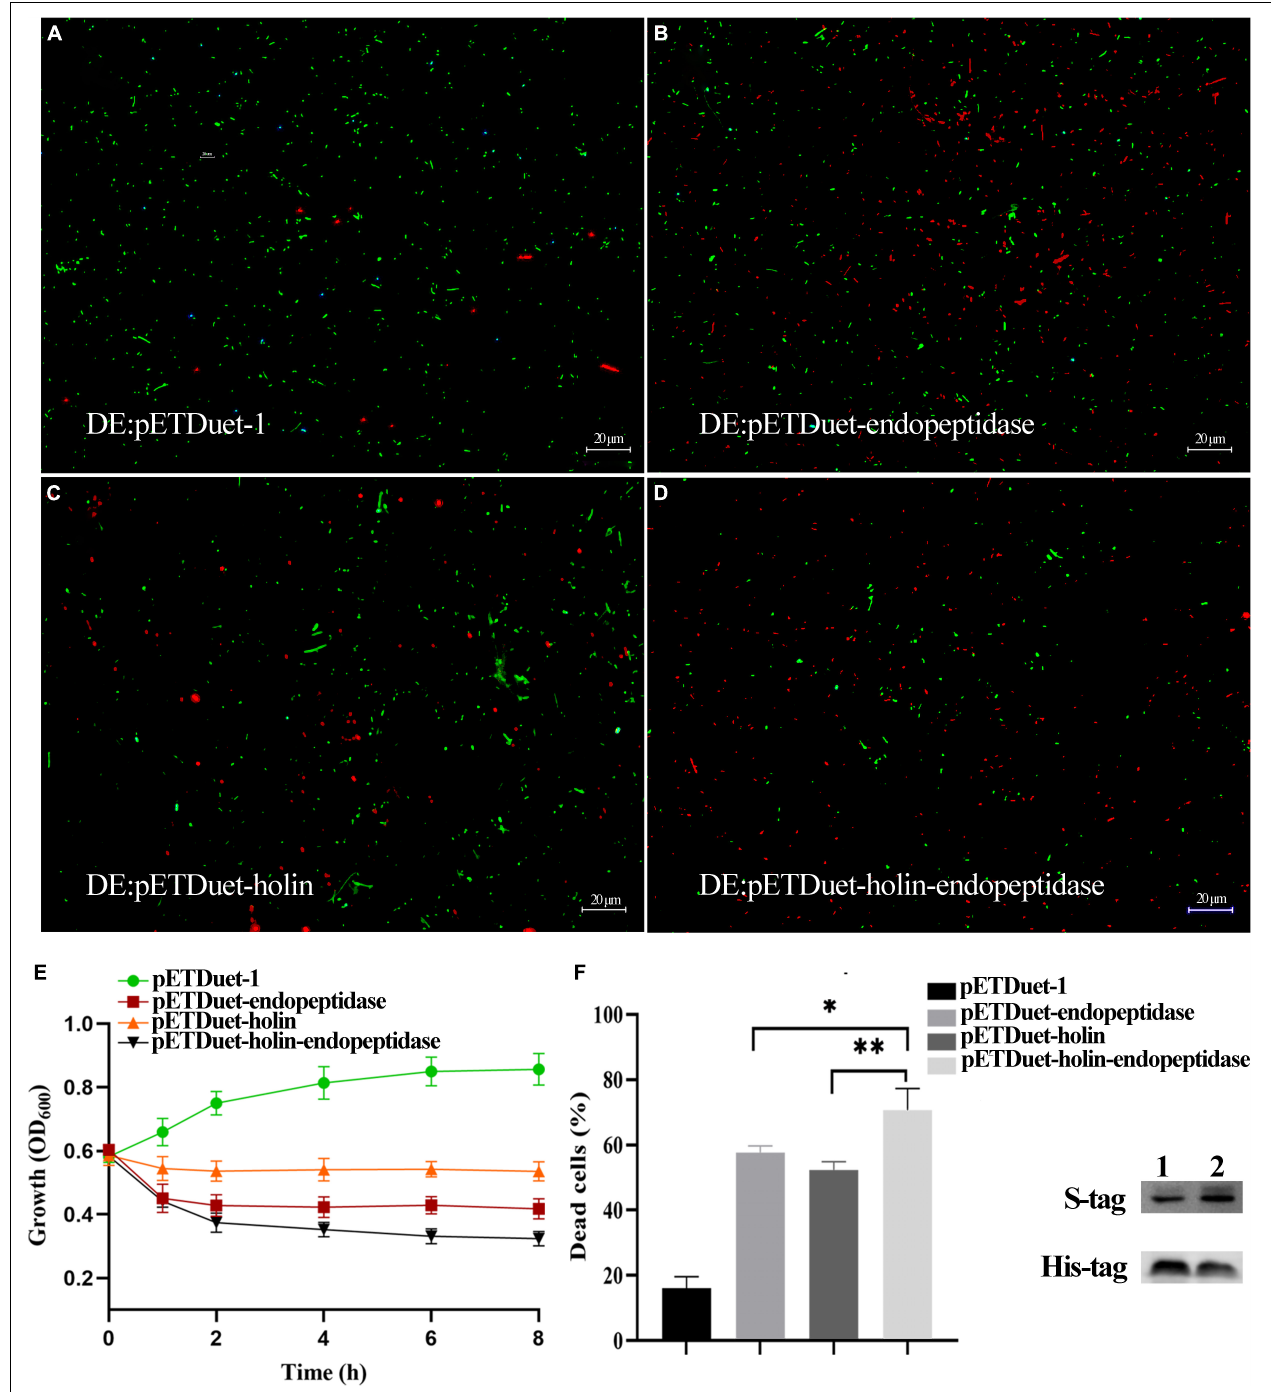
FIGURE 4 | Co-expression of endopeptidase and holin in E. coli BL21 (DE3). (A) Fluorescent staining of induced DE3: pETDuet-1. (B) Fluorescent staining of induced DE3: pETDuet-endopeptidase. (C) Fluorescent staining of induced DE3: pETDuet-holin. (D) Fluorescent staining of induced pETDuet-holin-endopeptidase. The cells with green fluorescence represent living bacterial cells, and those with red fluorescence represent dead cells. (E) The growth curves of induced different E. coli strains. (F) The percentage of dead cells of different E. coli strains. Lane 1: Western blotting was performed using total cellular proteins from IPTG-induced DE: pETDuet-endopeptidase or DE: pETDuet-holin. Lane 2: Western blotting was performed with total cellular proteins from IPTG-induced DE: pETDuet-holin-endopeptidase. The data were shown as means ± standard deviation from three independent experiments. The “ ∗ ” (T-test, p < 0. 05) and “ ∗∗ ” indicates statistical significance (T-test, p < 0.